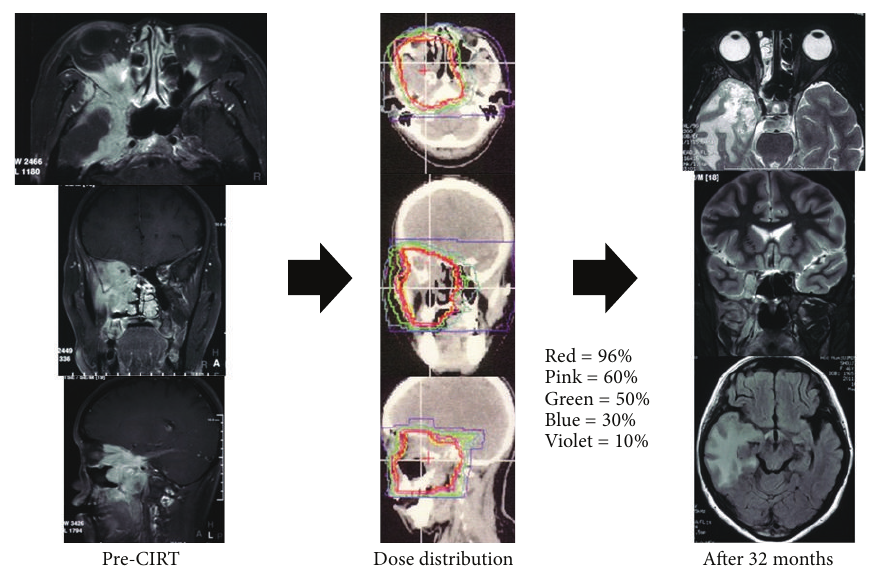
Figure 1: A case of 43-year-old Japanese female with adenoid cystic carcinoma in skull base. Axial, coronal, and sagittal contrast T1-weighted magnetic resonance image before carbon ion beam radiotherapy shows marginal enhancement and surrounding edema; dose distribution of carbon ion radiotherapy in axial CT image and axial contrast-enhanced T1-weighted magnetic resonance image 32 months after carbon ion beam radiotherapy show enhancement and edema in the right temporal lobe. This patient received no treatment for cerebral radiation injury. CIRT: carbon ion beam